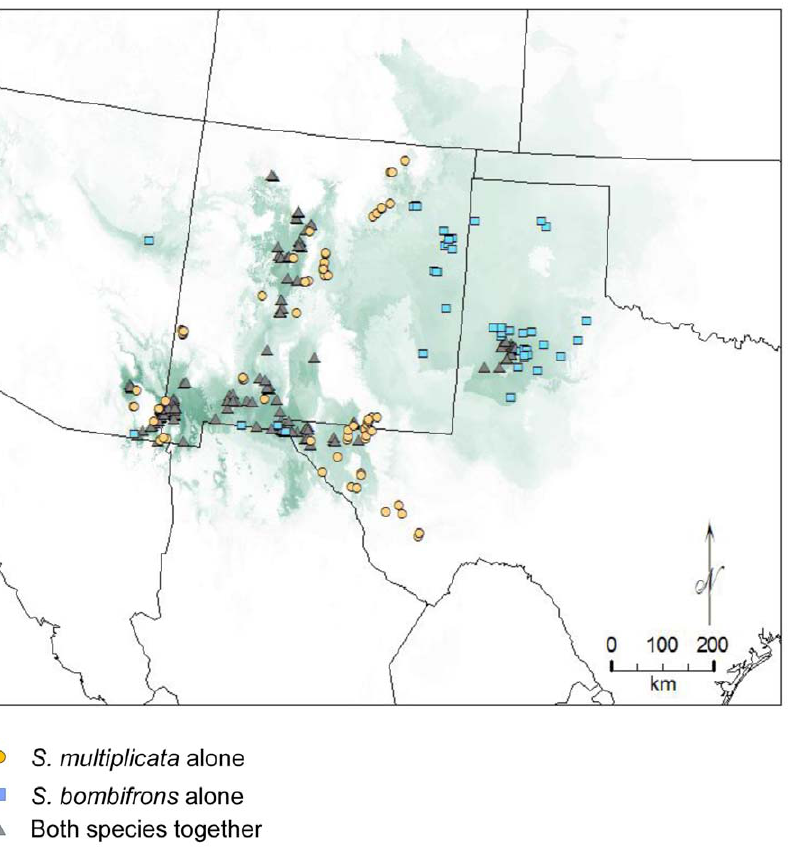
Figure 3. Range maps of predicted sympatry. Range maps of predicted sympatry between Spea multiplicata and S. bombifrons . The value for each 1 km sq pixel was calculated by multiplying the logistic value of both species, and values range from 0 (white) to 1 (dark green). Sites used in the environmental analysis are indicated by points. Specifically, blue squares represented collection locations for S. bombifrons that occurred in areas predicted to be allopatric for that species; orange circles represent collection locations for S. multiplicata records that were predicted to be allopatric for that species, whereas gray triangles represent collection locations for either species in areas predicted to be sympatric.